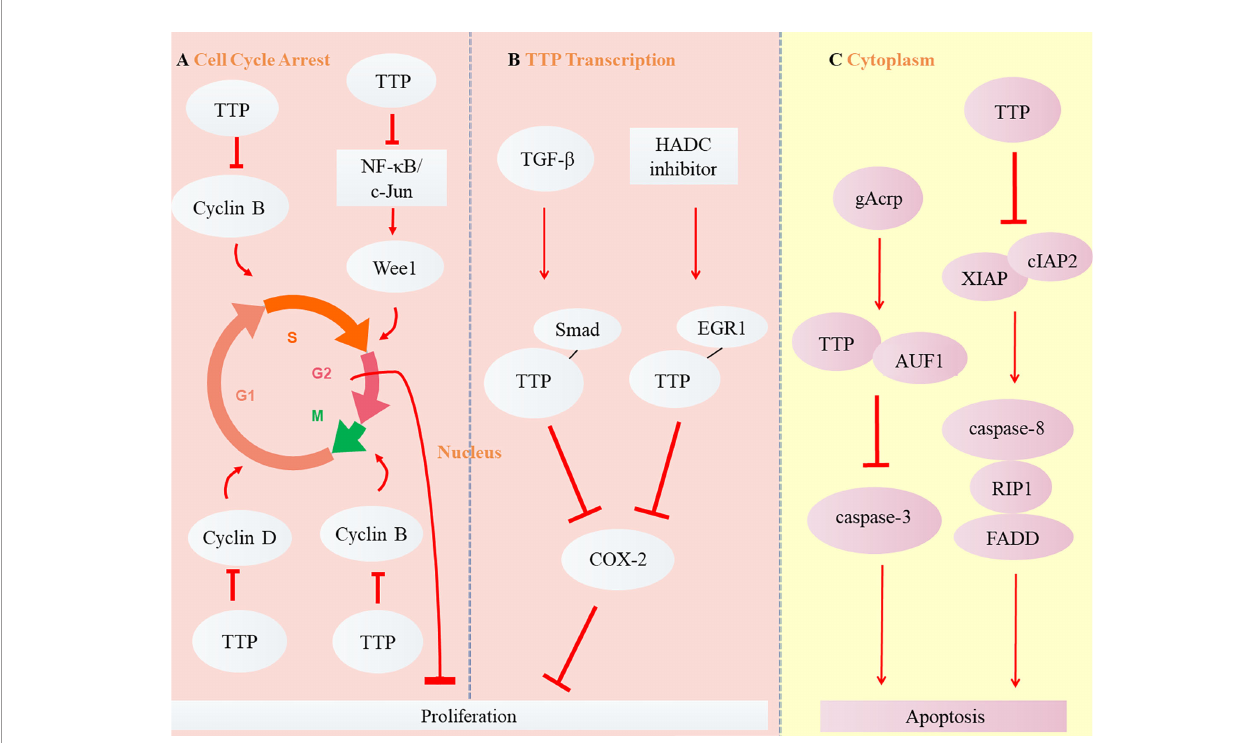
FIGURE 3 | Role of TTP in carcinoma. (A) TTP inhibits Cyclin B expression by inducing the arrest of cell cycle from Phase G1 to S or G2 to M, Cyclin D expression in Phase G1, and Wee1 expression from Phase S to G2, thus suppressing the proliferation of cancer cells. (B) The transcription of TTP, induced by TGF- b and HADC inhibitor, binds with the other transcription factors, Smad and EGR1. Subsequently, TTP inhibits COX-2 expression and suppresses the proliferation of cancer cells. (C) Two cytoplasmic signaling pathways of TTP are involved in the apoptosis of tumor